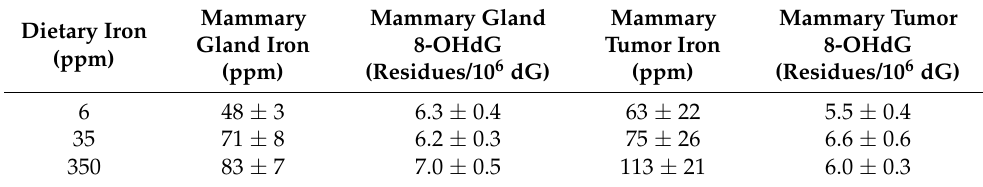
Table 8. Effect of dietary iron on mammary gland and tumor levels of iron and